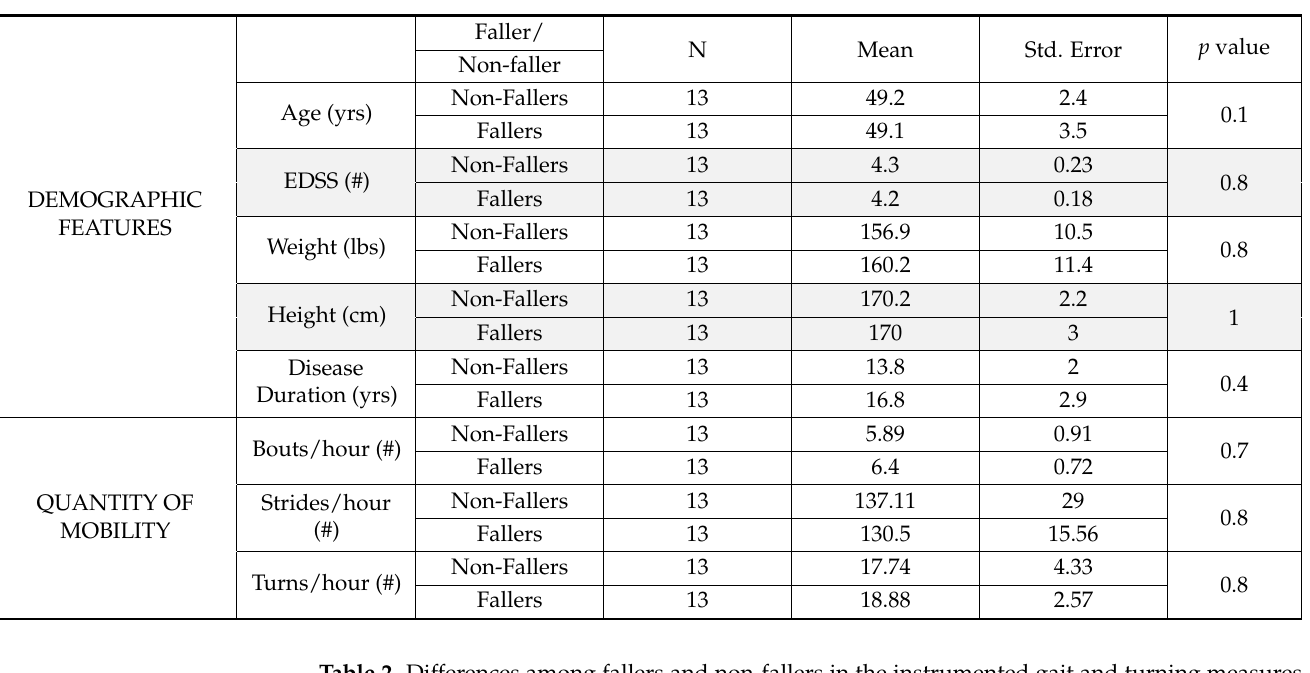
Table 2. Differences among fallers and non-fallers in the instrumented gait and turning measures collected during the daily home